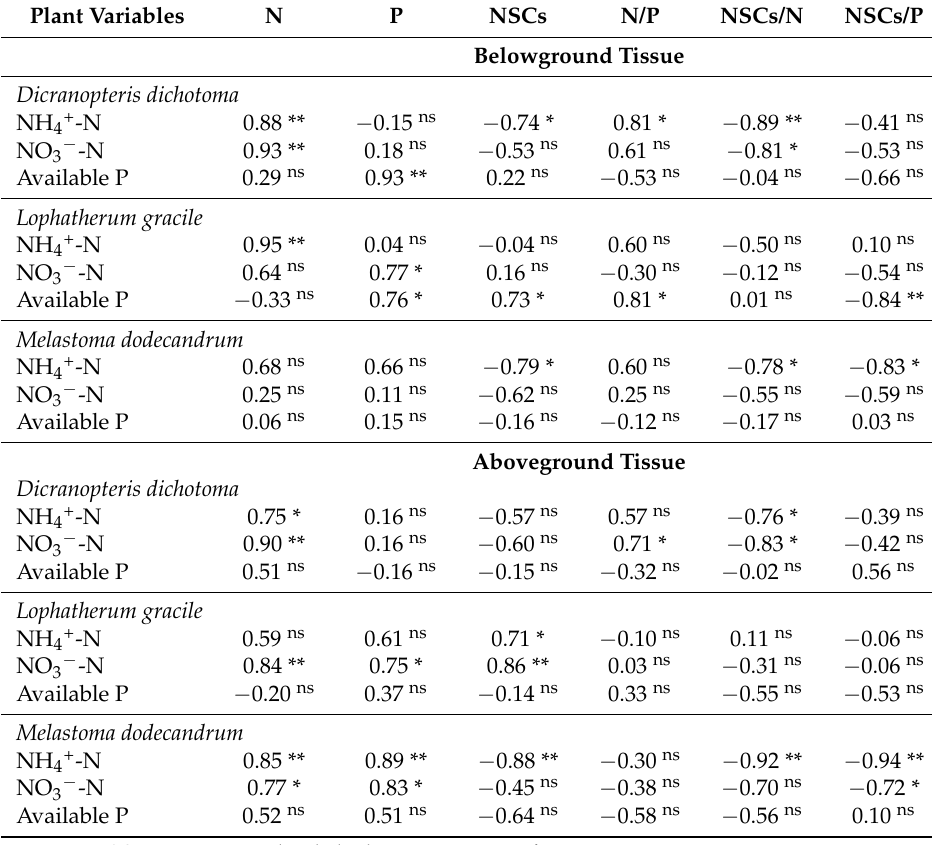
Table 3. The correlation coefficients ( n = 8) between plant tissue and rhizosphere soil nutrients for each of the three understory plant species in the Chinese fir